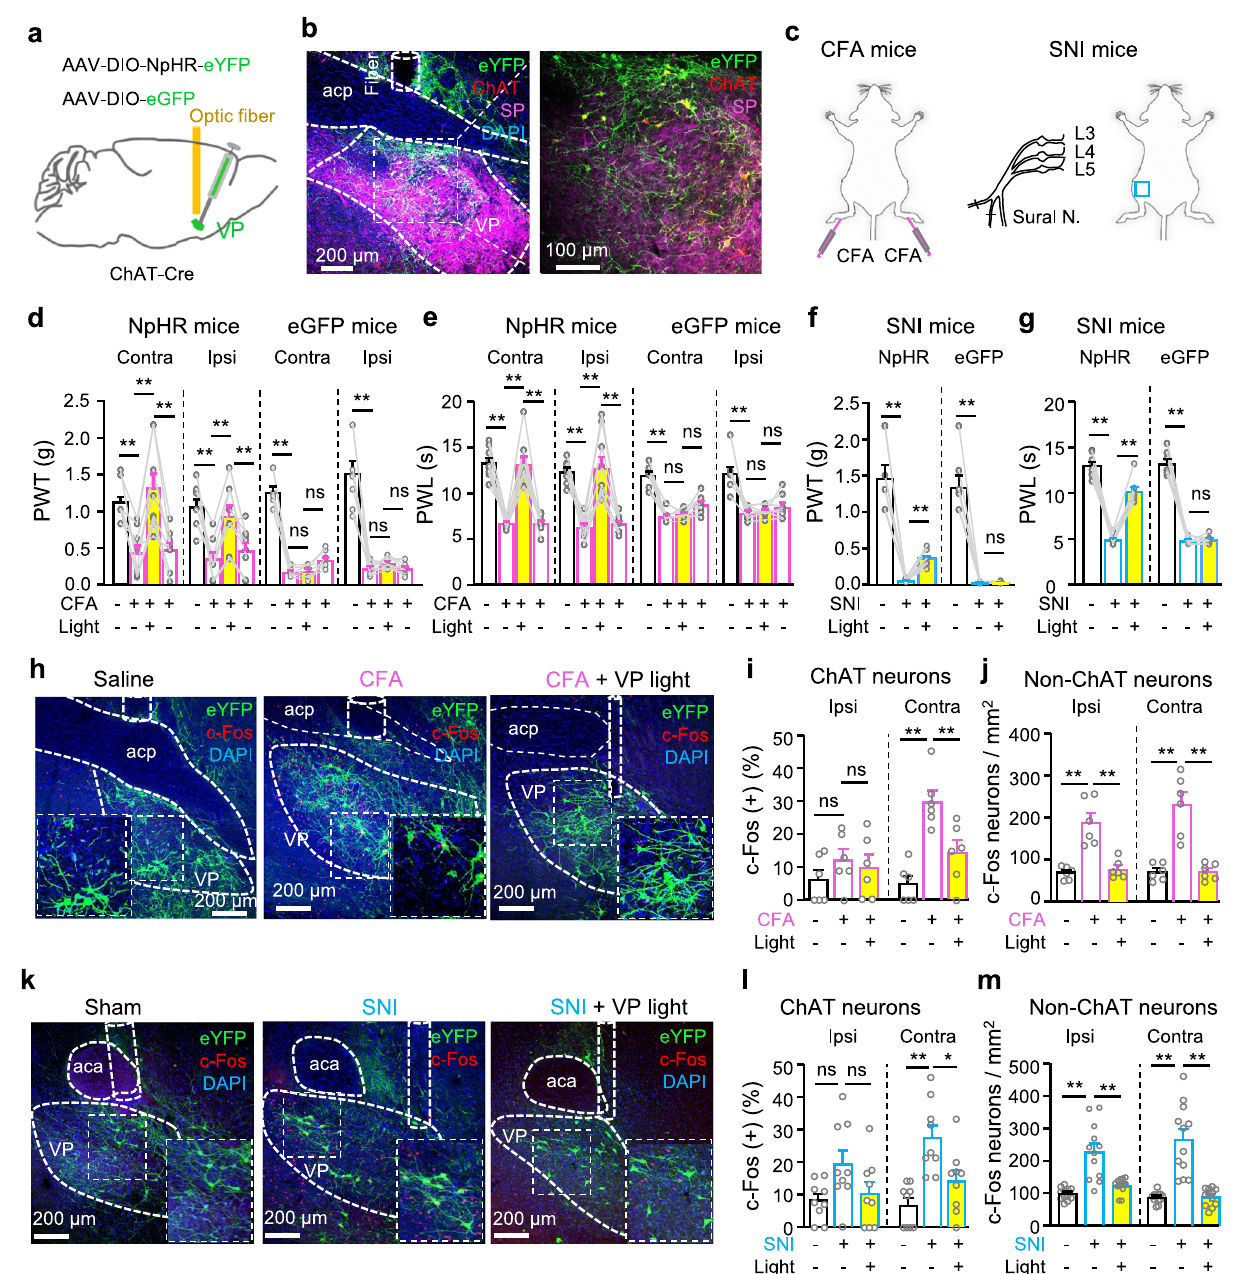
Fig. 6 | Optogenetic inhibition of VP ChAT neurons mitigates the reduction in pain thresholds in persistent pain. a , b Schematic diagram and a representative image out of 9 for optogenetic (NpHR) inhibition of VP ChAT neurons. c Establishment of pain mouse models. d , e PWT and PWL for both hind paws of NpHR ( n =9) and eGFP ( n =8) mice before, during, and after yellow-light illumi- nationoftherightVP,correspondingtobeforeand24,48,72hafterCFAinjection. f , g PWTandPWLonthelefthindpawofNpHR( n =8)andeYFP( n =7)micebefore and during yellow light in the right VP in SNI mice. f NpHR: F (1.060, 7.420) =53.90, P =0.0001; t =8.24, df=7, P =0.0001,baselinevs SNI; t =8.75, df=7, P <0.001,SNI vs SNI-VP-light. eYFP: F (1.002, 6.010) =67.52, P =0.0002; t =8.19, df=6, P =0.0004, baseline vs SNI; t =0.39, df=6, P =0.71, SNI vs SNI-VP-light. g NpHR: F (1.321,